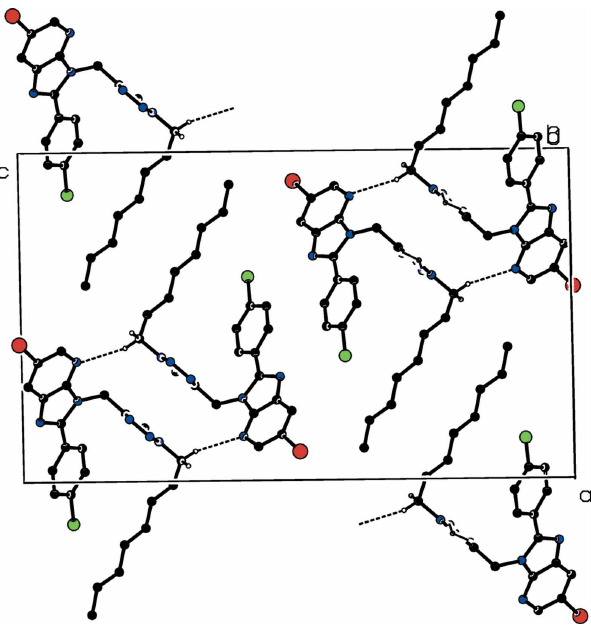
Figure 3 Packing viewed along the b -axis direction. C—H (cid:3)(cid:3)(cid:3) N I hydrogen bonds are shown by dashed lines.